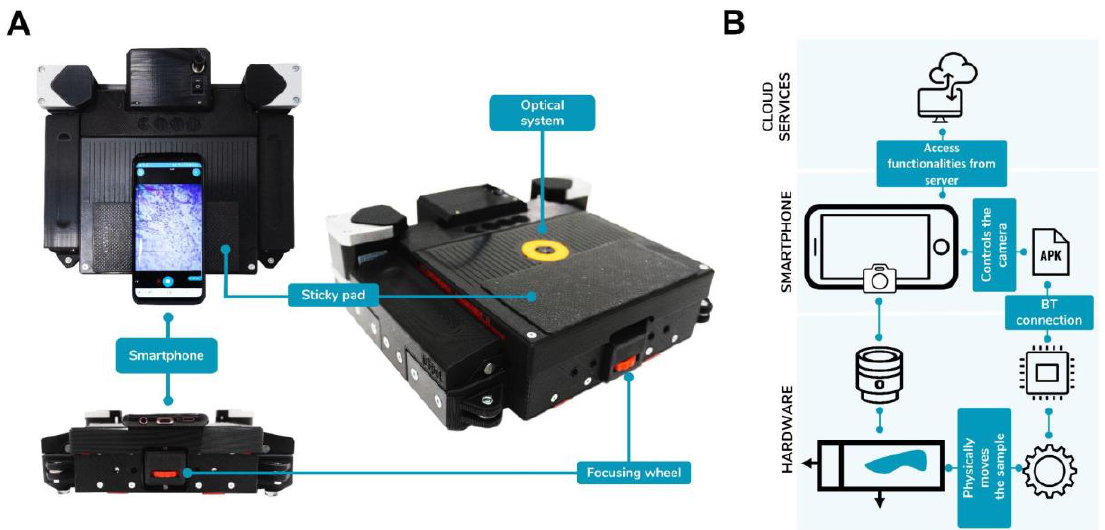
Figure 1. ( A ) Overview of the design of the proposed device. The phone is placed so it is aligned with the optics. Focusing wheel is used to move the vertical axis of the system for optical focus. ( B ) Interaction between the 3 main components of the device, including the hardware, the smartphone and cloud services.